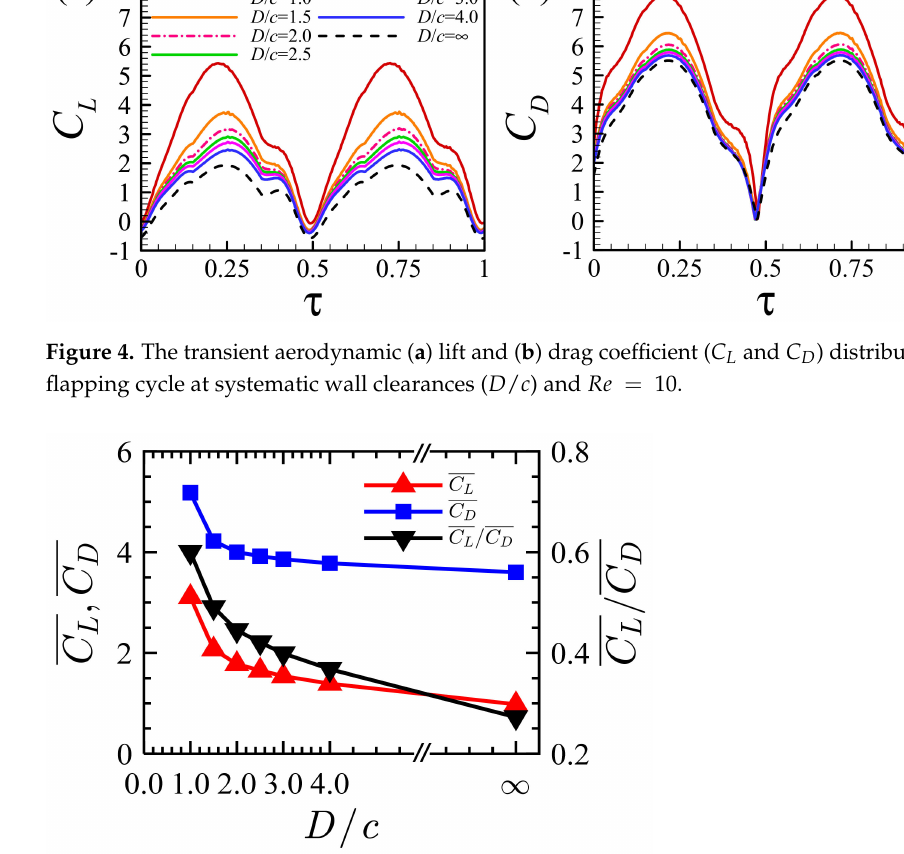
Figure 5. Cycled-averaged lift ( C L ) and drag ( C D ) coefficients and lift–drag ratio ( C L / C D ) versus wall clearance ( D / c ) at Re =